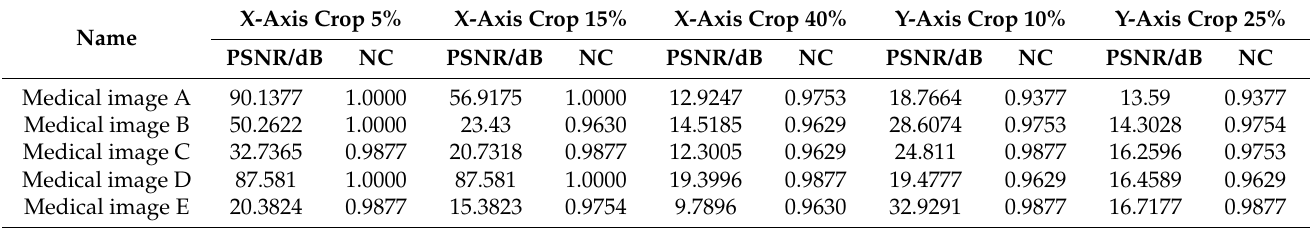
Table 6. The result under cropping attacks.